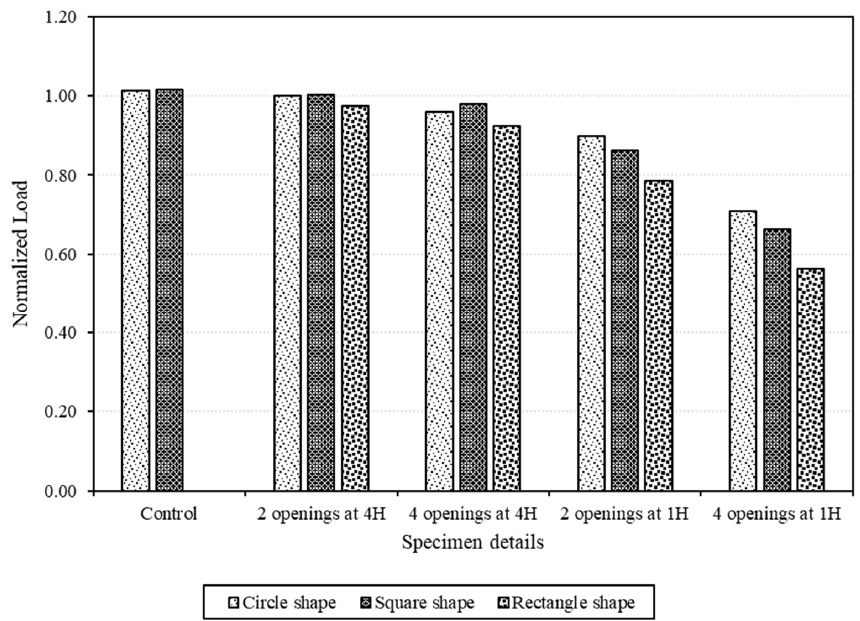
Figure 15. Comparison between square, circle, and rectangle shape.